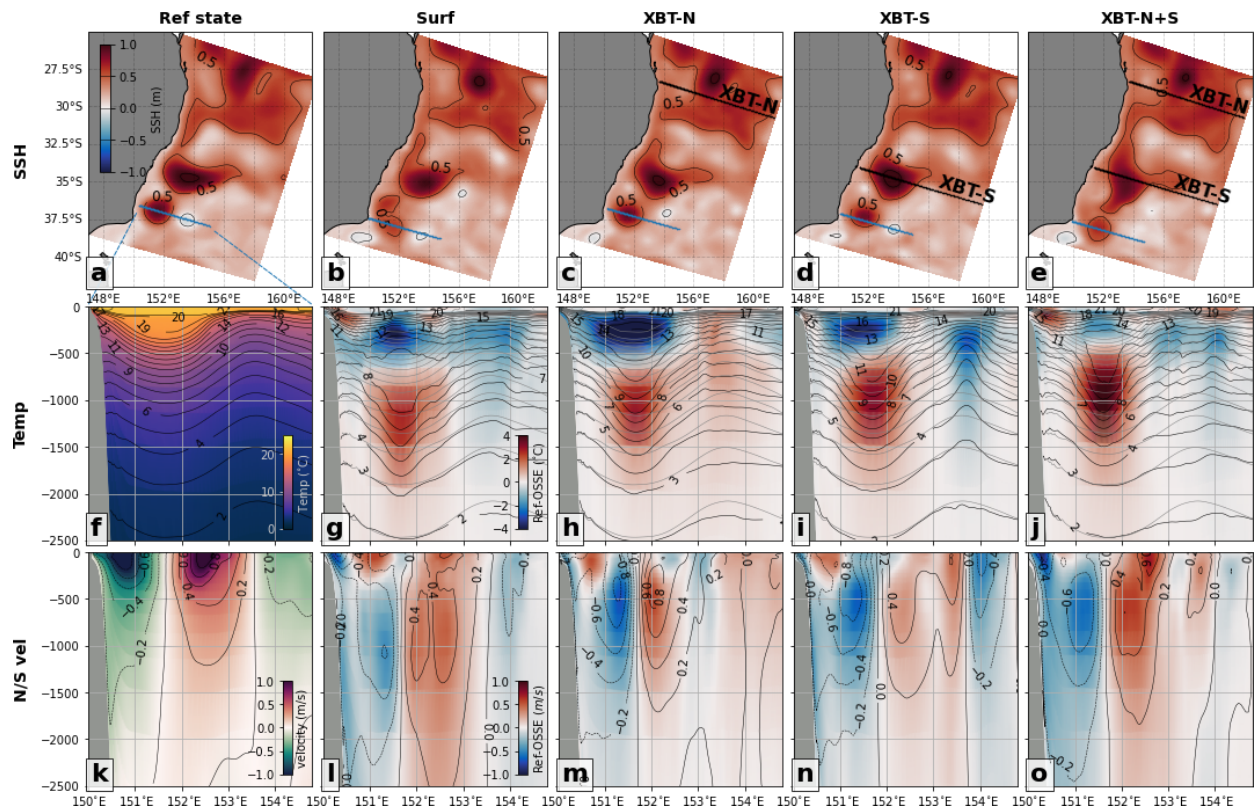
Figure 7. The vertical representation of an anticyclonic–cyclonic eddy pair at ∼ 37.5 ◦ S, 151.5–153.5 ◦ E in the (a) Ref state is compared to the (b) Surf, (c) XBT-N, (d) XBT-S, and (e) XBT-N+S OSSEs, with the SSH field and vertical profile location marked by a blue line. The vertical temperature profile along the transect is shown for the (f) Ref state and the (g) Surf, (h) XBT-N, (i) XBT-S, and (j) XBT-N+S OSSEs. Likewise, (k–o) northward velocity profiles are shown for the same experiments. In the OSSE panels, the difference in temperature and velocity from the Ref state plotted in colour and contours of (dark colour) the OSSE and (light colour) the respective field in the Ref state are shown for comparison. In panel (a) , the blue dashed lines indicate the transect shown in (f) . The XBT-N and XBT-S transect locations are marked in the respective panels. Axes with latitudes are labelled ◦ S, and axes with longitudes are labelled ◦